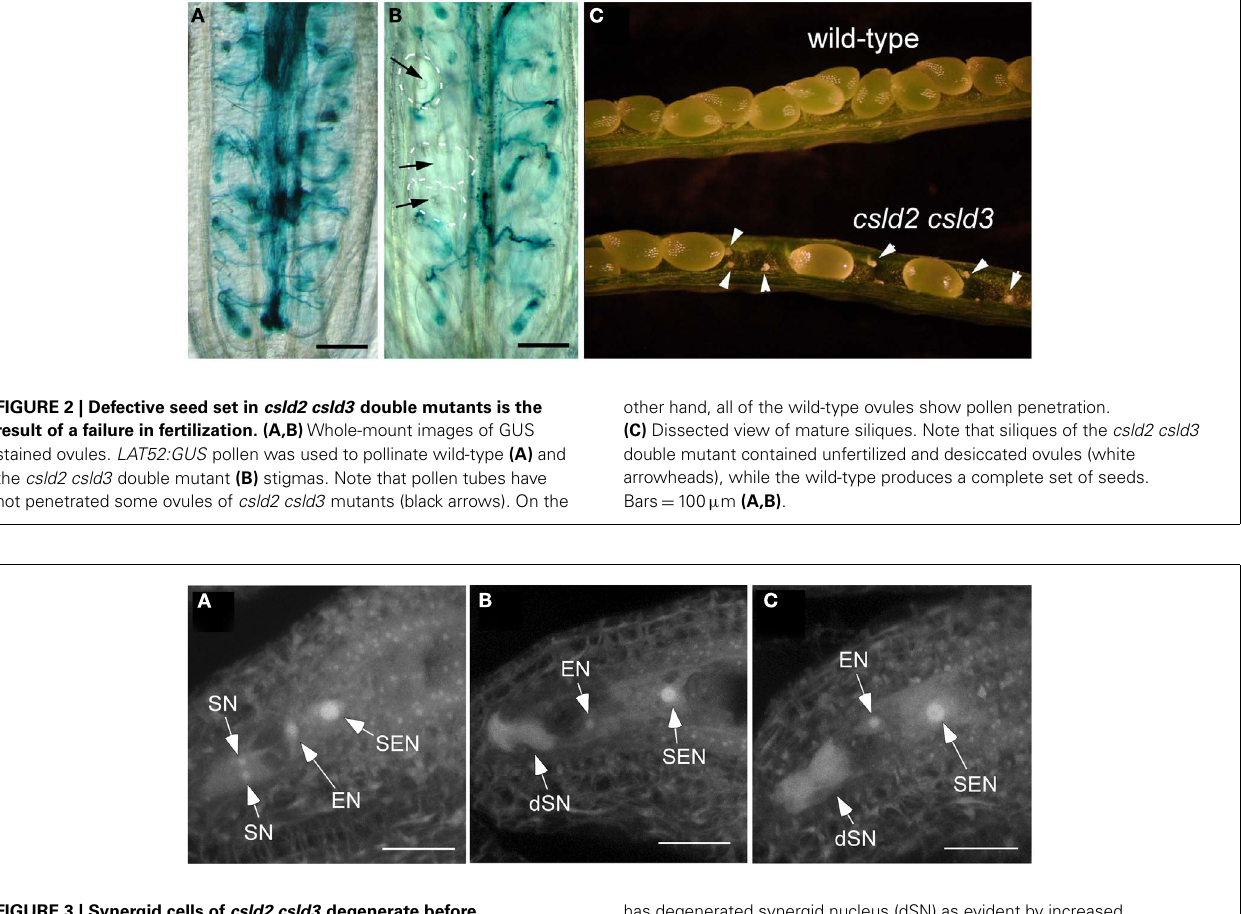
FIGURE 3 | Synergid cells of csld2 csld3 degenerate before fertilization. (A) Secondary endosperm nucleus (SEN), egg cell nucleus (EN), and the two synergid cell nuclei (SN) in the wild-type. (B,C) Show images at the same stage of female gametophyte development (FG7) in csld2 csld3 double mutant. Note that csld2 csld3